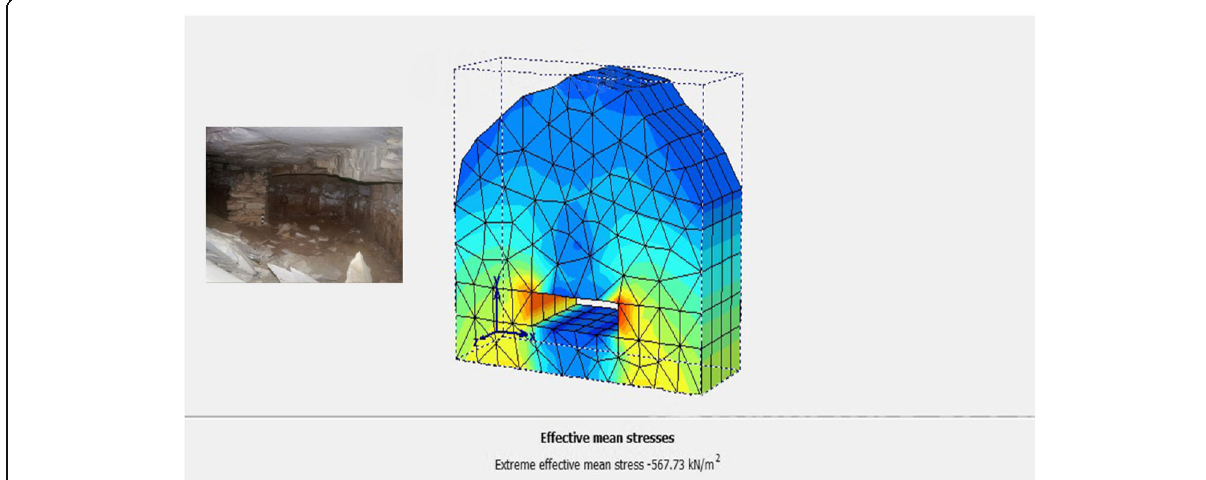
Fig. 30 Effective mean stresses in the ceiling and sidewalls of northern Chamber. PLAXIS